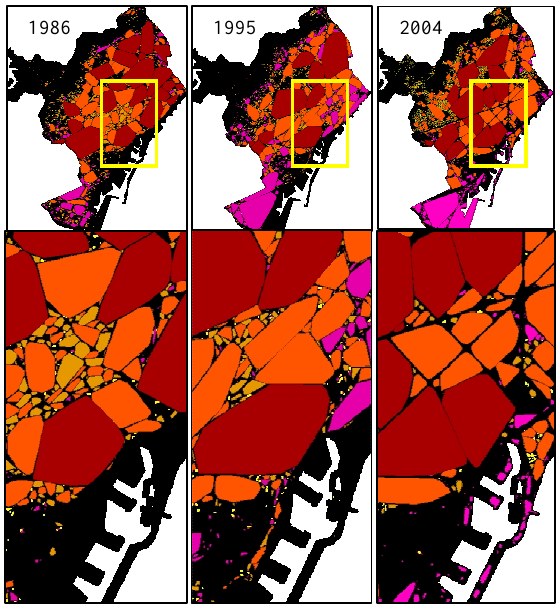
Figure 8: (Right) reform urban clusters areas using convex hull algorithm.